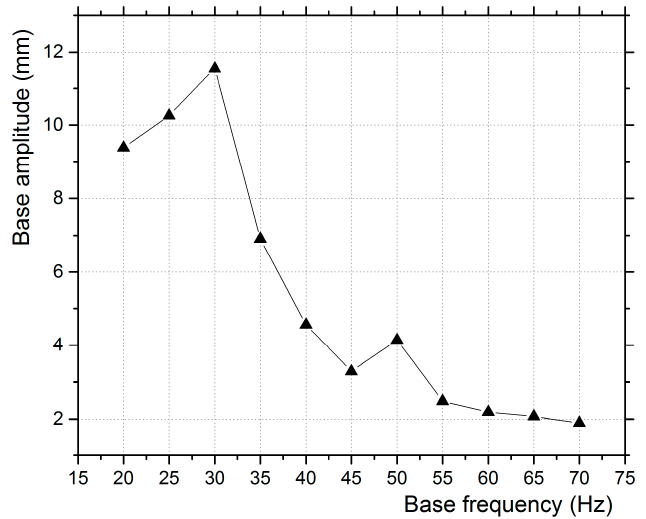
Figure 4. Frequency vs. amplitude diagram of the cone speaker.